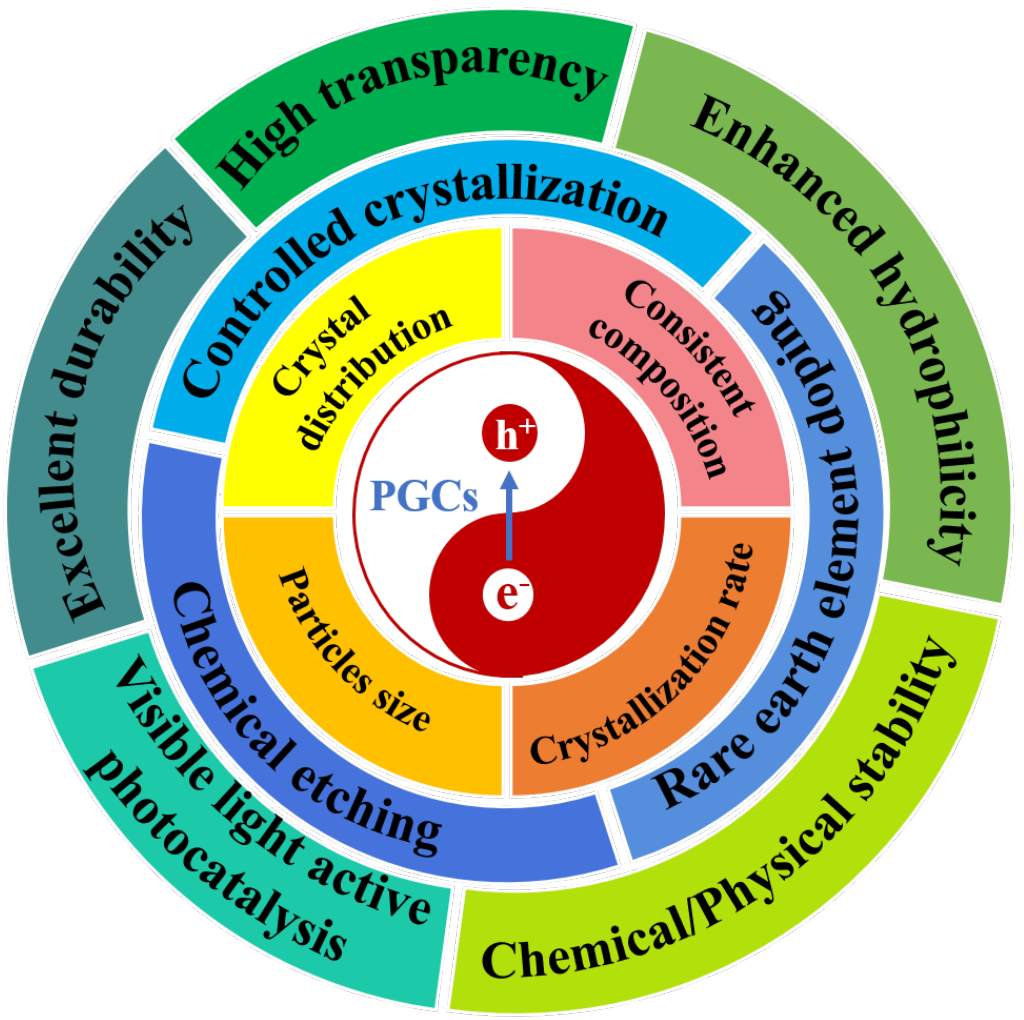
Figure 7. Schematic representation of design considerations of PGCs.